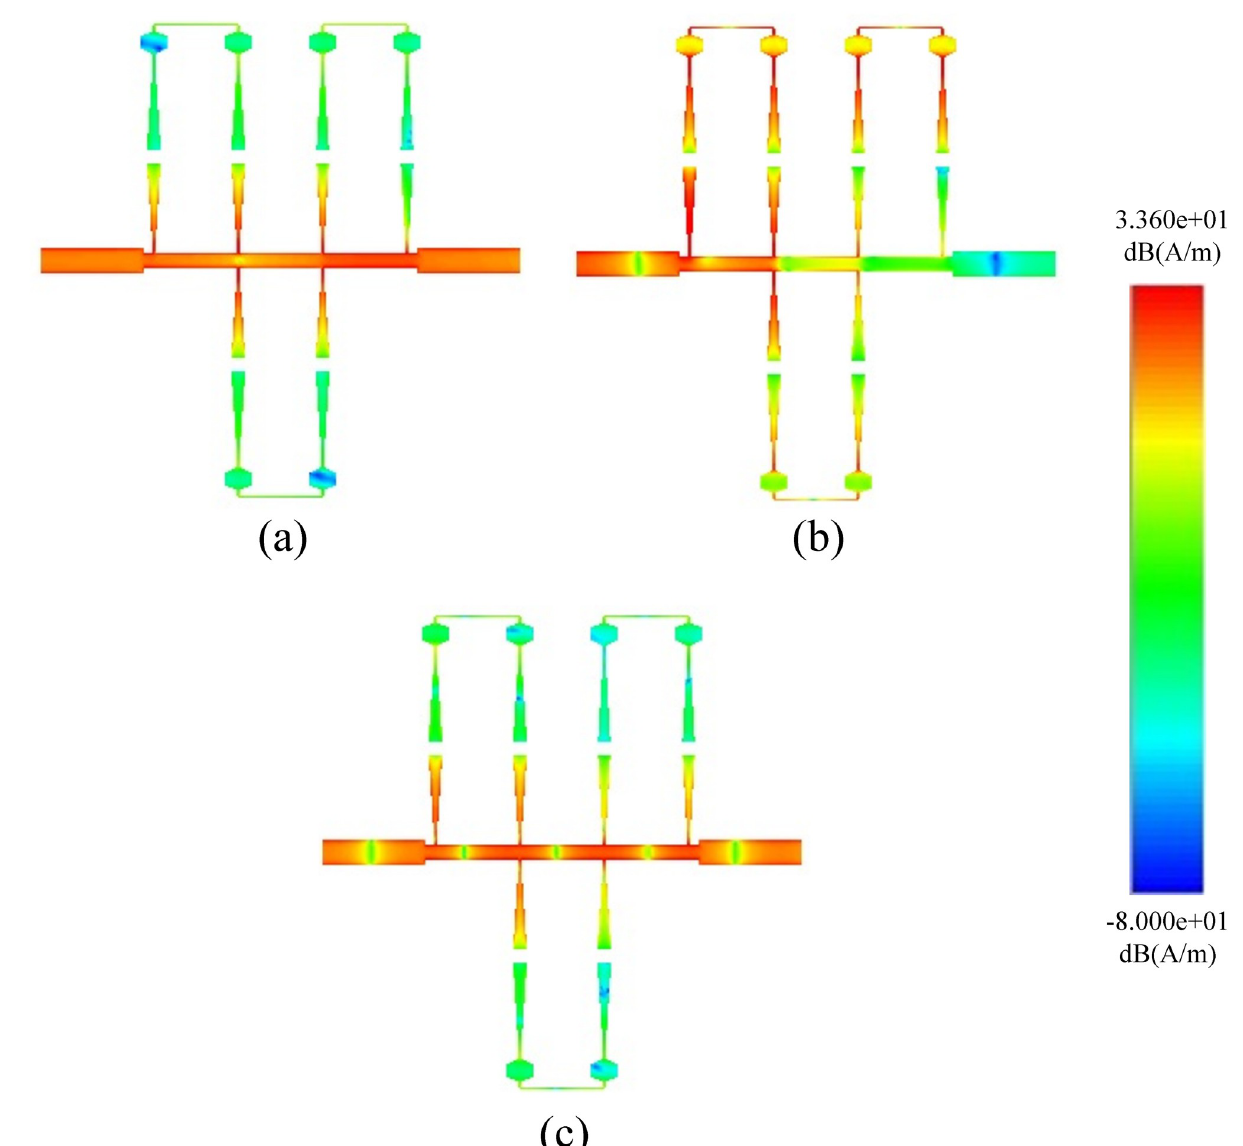
Fig 14. Current distribution of third-order BSF.